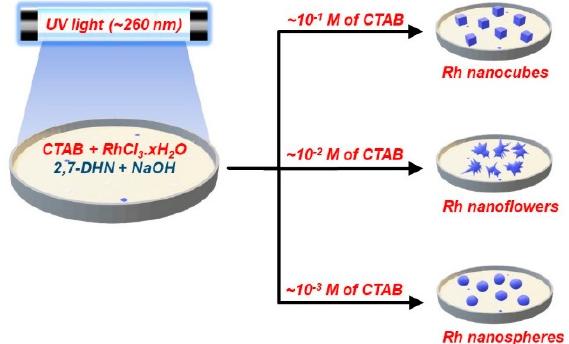
Figure 8. The Kundo et al. [92] micellar-media synthesis method for generating different shapes of Rh NPs depending on the CTAB surfactant concentrations, redrawn by the authors from the reference.